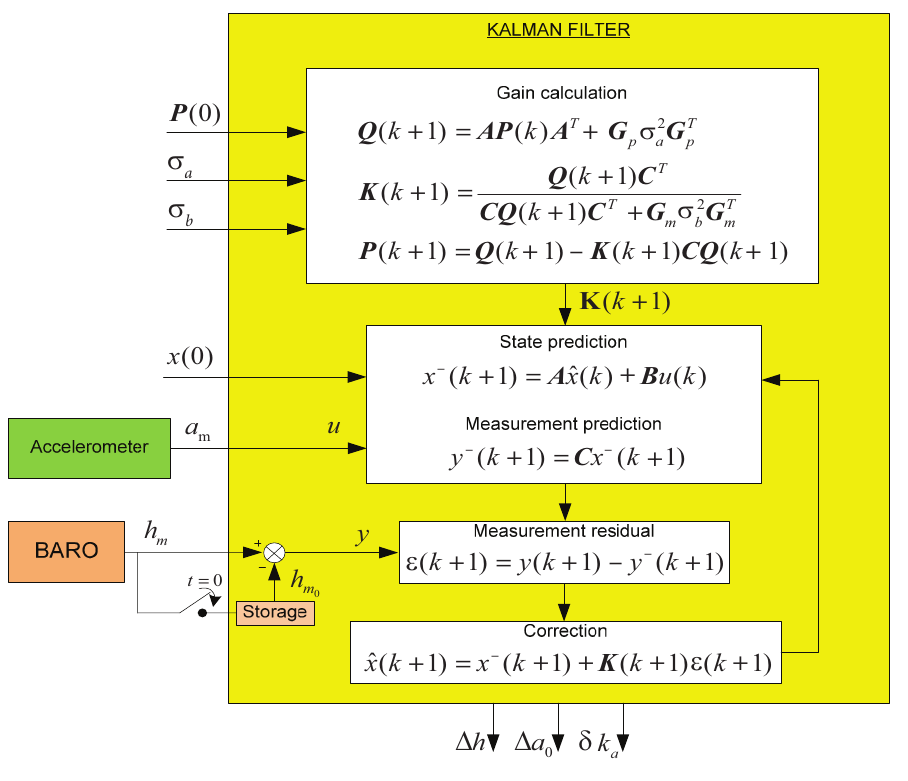
Figure 1. Calibration Kalman